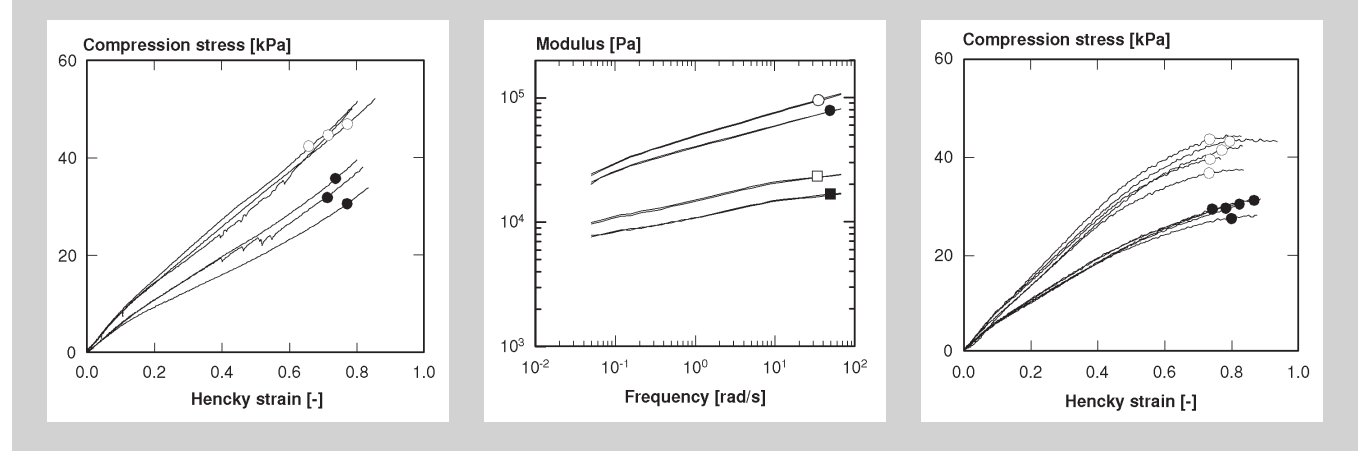
Fig. 2 (left): Stress/strain curves of processed model cheeses: ( Á ) cheeses made with the fat fraction solid at 30°C; ( Ë ) cheeses made with the fat fraction liquid at 24°C. Fig. 3 (middle): Mechanical spectra of processed model cheeses: ( Á ) cheeses made with the fat fraction solid at 30°C; ( · ) cheeses made with the fat fraction liquid at 24°C ( Á - storage modu- lus, Ë - loss modulus). Fig. 4 (right): Stress/strain curves of processed Gruyère cheeses: ( Á ) made from winter Gruyère; ( Ë ) made from summer